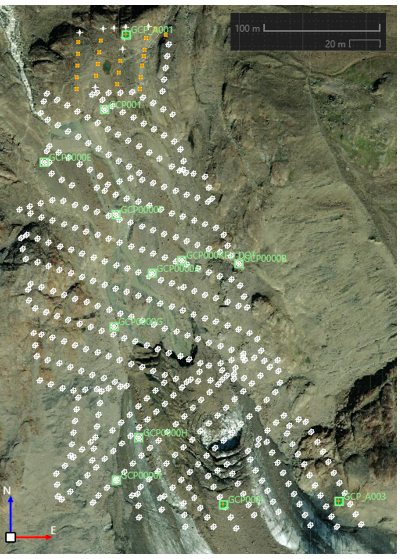
Table 3. Assessment with UAV track post-processing and